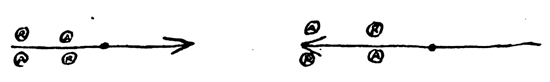
 The needle is imagined as fixed, the wire as in motion. The positions of the wire can now be construed as forming points on a plane figure.